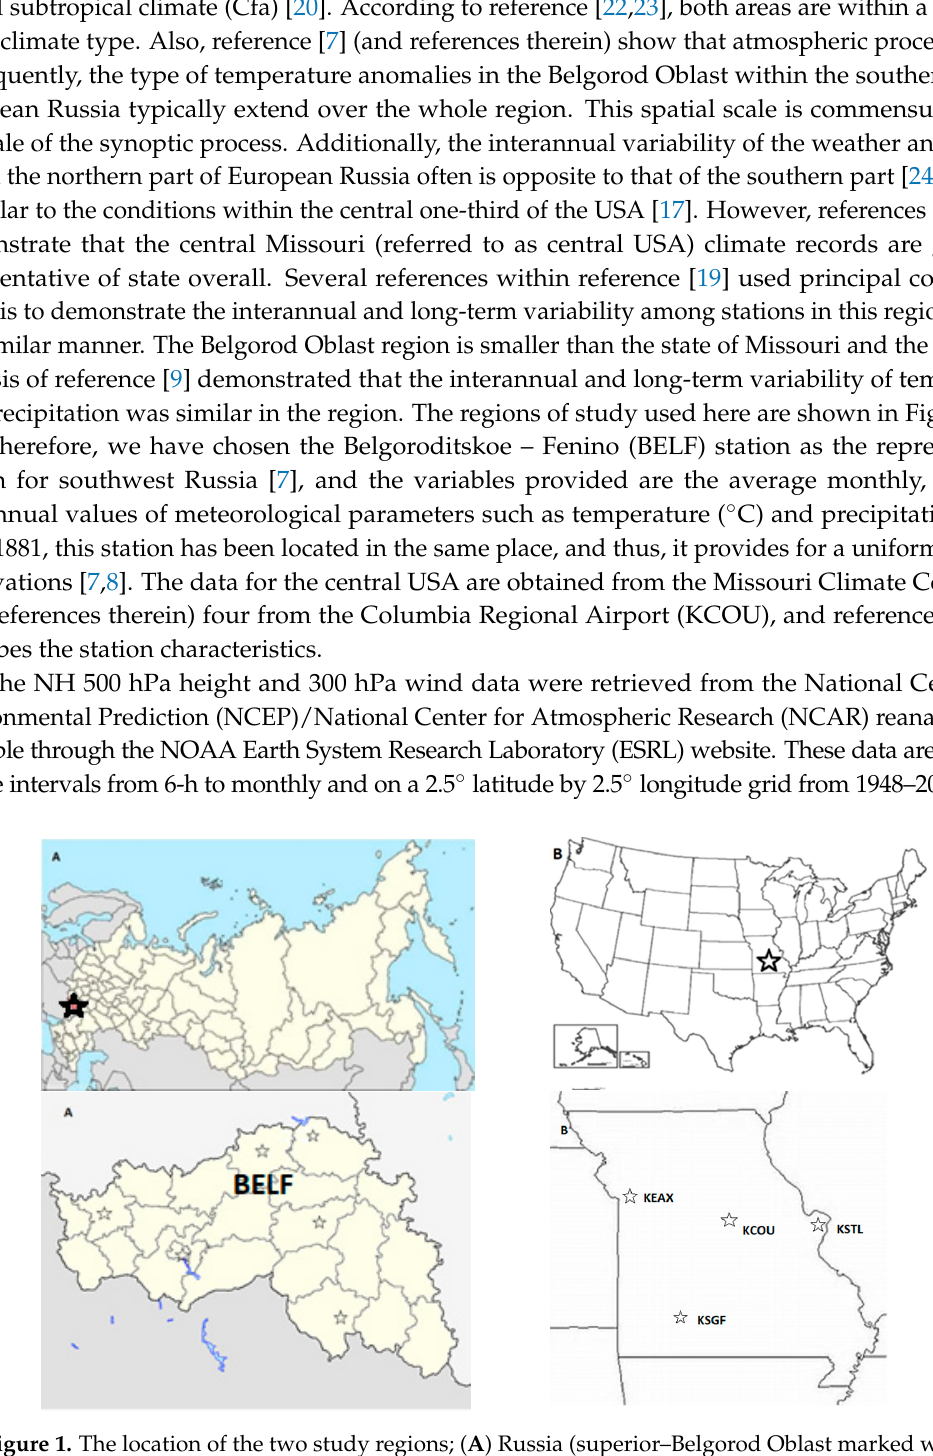
Figure 1. The location of the two study regions; ( A ) Russia (superior–Belgorod Oblast marked with a star) and Belgorod Oblast (inferior–station used is BELF), and ( B ) the United States (superior–Missouri marked with a star) and State of Missouri (inferior–station used is KCOU).